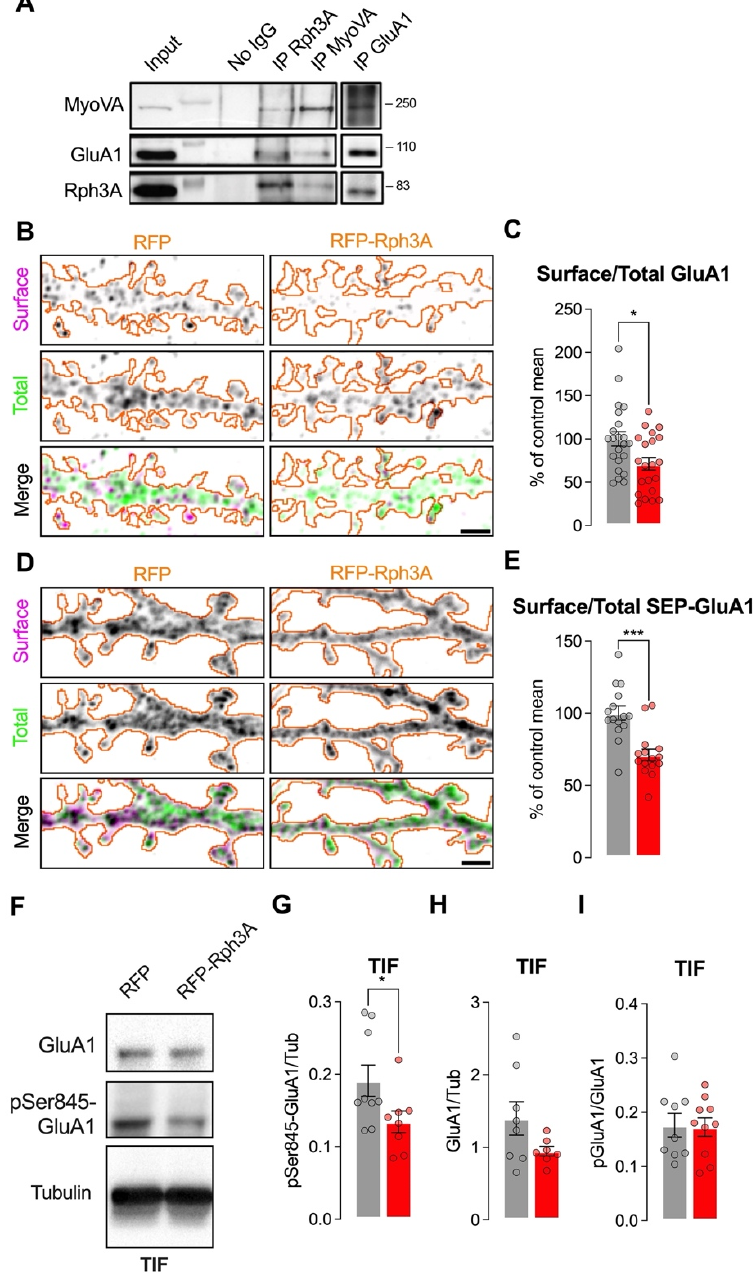
Figure 5. Rph3A overexpression alters GluA1-AMPAR phosphorylation and surface levels. ( A ): Western blot images of Rph3A/MyoVA/GluA1 co-immunoprecipitation from hippocampal lysates. ( B ): Confocal images of surface (magenta) and total GluA1 (green) staining in RFP ( left ) or RFP- Rph3A ( right ) transfected neurons (orange outline). Scale bar: 2 µm. ( C ): Bar graph representing mean ± SEM of percentage of control mean of GluA1 surface/total ratio, unpaired t -test. ( D ): Confo- cal images of surface (magenta) and total SEP-GluA1 (green) staining in RFP ( left ) or RFP-Rph3A ( right ) transfected neurons (orange outline). Scale bar: 2 µm. ( E ): Bar graph representing mean ± SEM of percentage of control mean of SEP-GluA1 surface/total ratio, unpaired t -test. ( F ): Western blot images of pSer845-GluA1, GluA1 and tubulin from the triton insoluble fraction (TIF) of hippo- campal cultured neurons infected with AAV9-hSyn-RFP-WPRE or AAV9-hSyn-RFPRph3A-WPRE. ( G ): Bar graph representing mean ± SEM of the pSer845-GluA1/tubulin staining ratio from the TIF of hippocampal cultured neurons infected with AAV9-hSyn-RFP-WPRE or AAV9-hSyn- RFPRph3A-WPRE, Mann–Whitney U test. ( H ): Bar graph representing mean ± SEM of the GluA1/tubulin staining ratio from the TIF of hippocampal cultured neurons infected with AAV9-